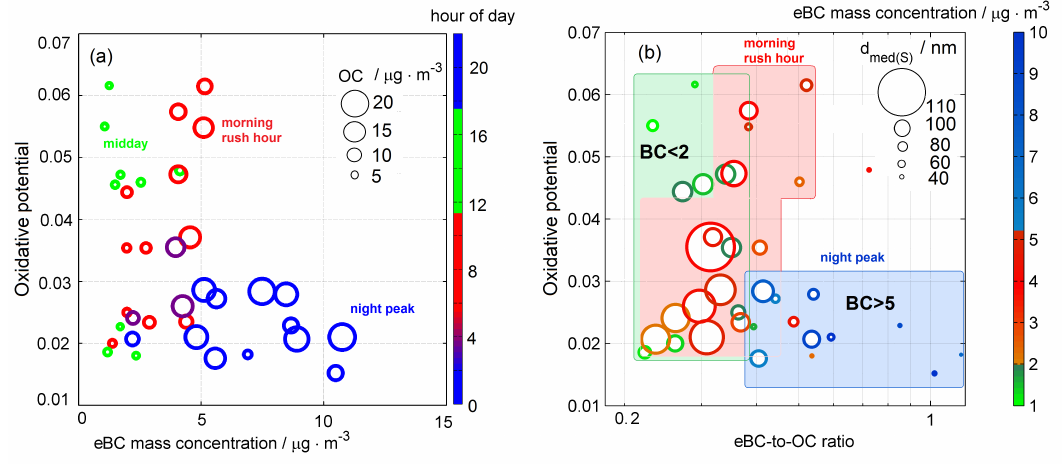
Figure 14. Dependence of the oxidative potential (OP) associated with particulate matter on particle composition, size, and time. The OP is expressed in arbitrary units, i.e., fluorescence intensity resulting from the oxidation of the non-fluorescent DCFH to the fluorescent dichlorofluorescein (DCF) in the presence of horseradish peroxidase (HRP). The OP is showed versus : (panel ( a )) the eBC mass concentration; and (panel ( b )) the eBC-to-OC ratio. Markers are sized according to the scale presented of: (panel ( a )) OC mass concentration; and (panel ( b )) median diameter of particle surface size distribution (d med ( S ) ). Colour bars to the right indicate colours used for markers: (panel ( a )) hour of day (green for weekends at midday, red for morning rush hour of working days, and blue for evening peak of for < 2 µ g · m − 3 , red in the range 2–5 µ g · m − 3 , and blue for > 5 µ g · m − 3 ). The three shaded